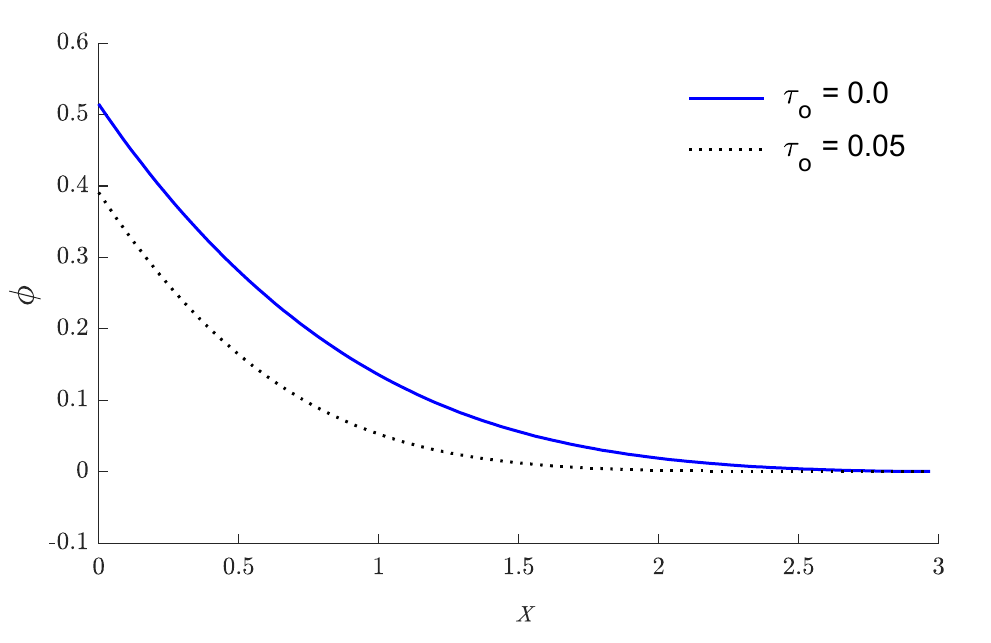
Figure 7. The electric potential distribution via the distance x with and without thermal relaxation time. When α = 0.1: